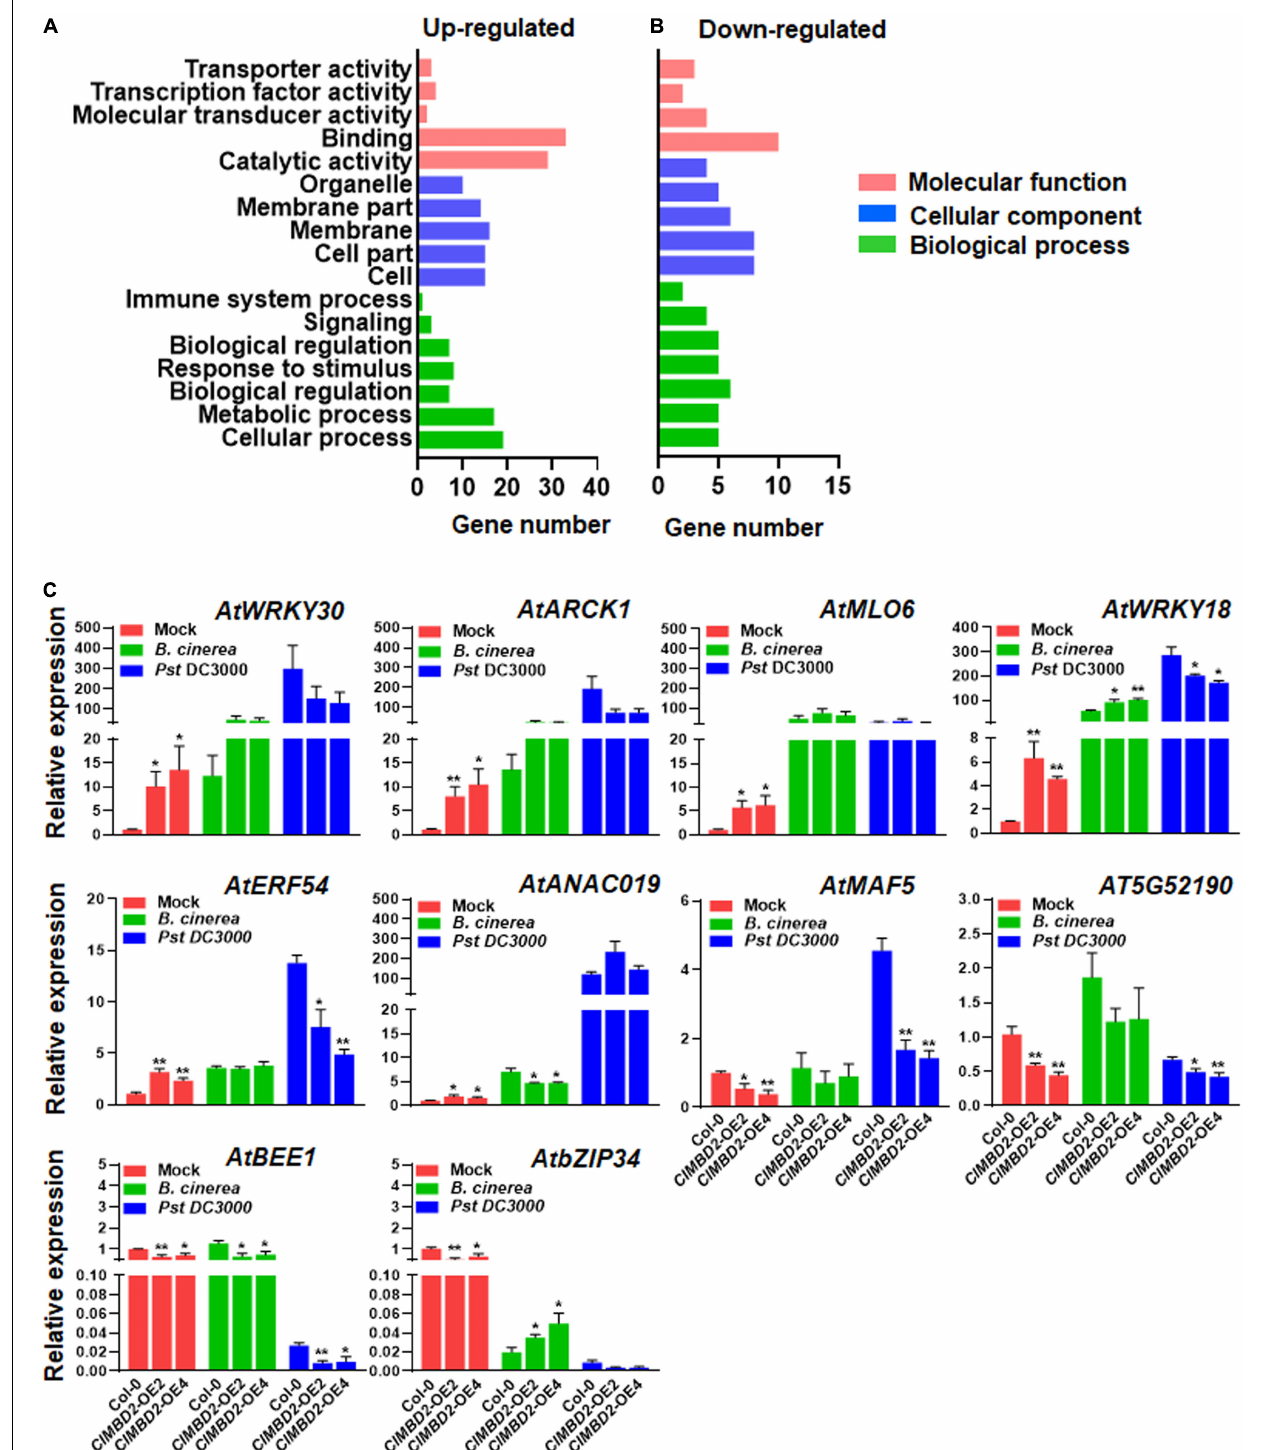
FIGURE 8 | Differentially expressed genes in ClMBD2 -OE2 plants. (A,B) Enriched GO terms of up-regulated (A) and down-regulated (B) genes in ClMBD2 -OE2 plants, in comparison to WT plants. (C) qRT-PCR validation of expression patterns of selected differentially expressed genes in ClMBD2 -OE and WT plants with or without infection of B. cinerea or Pst DC3000 at 24 hpi. Relative expression of the selected genes was analyzed by qRT-RCR using AtActin as an internal control. Data presented in (C) are the means ± SE from three independent experiments and * or ** above the columns indicate significant differences at p < 0.05 or p < 0.01 levels (Student’s t -test), respectively, between the ClMBD2 -OE plants and WT plants.